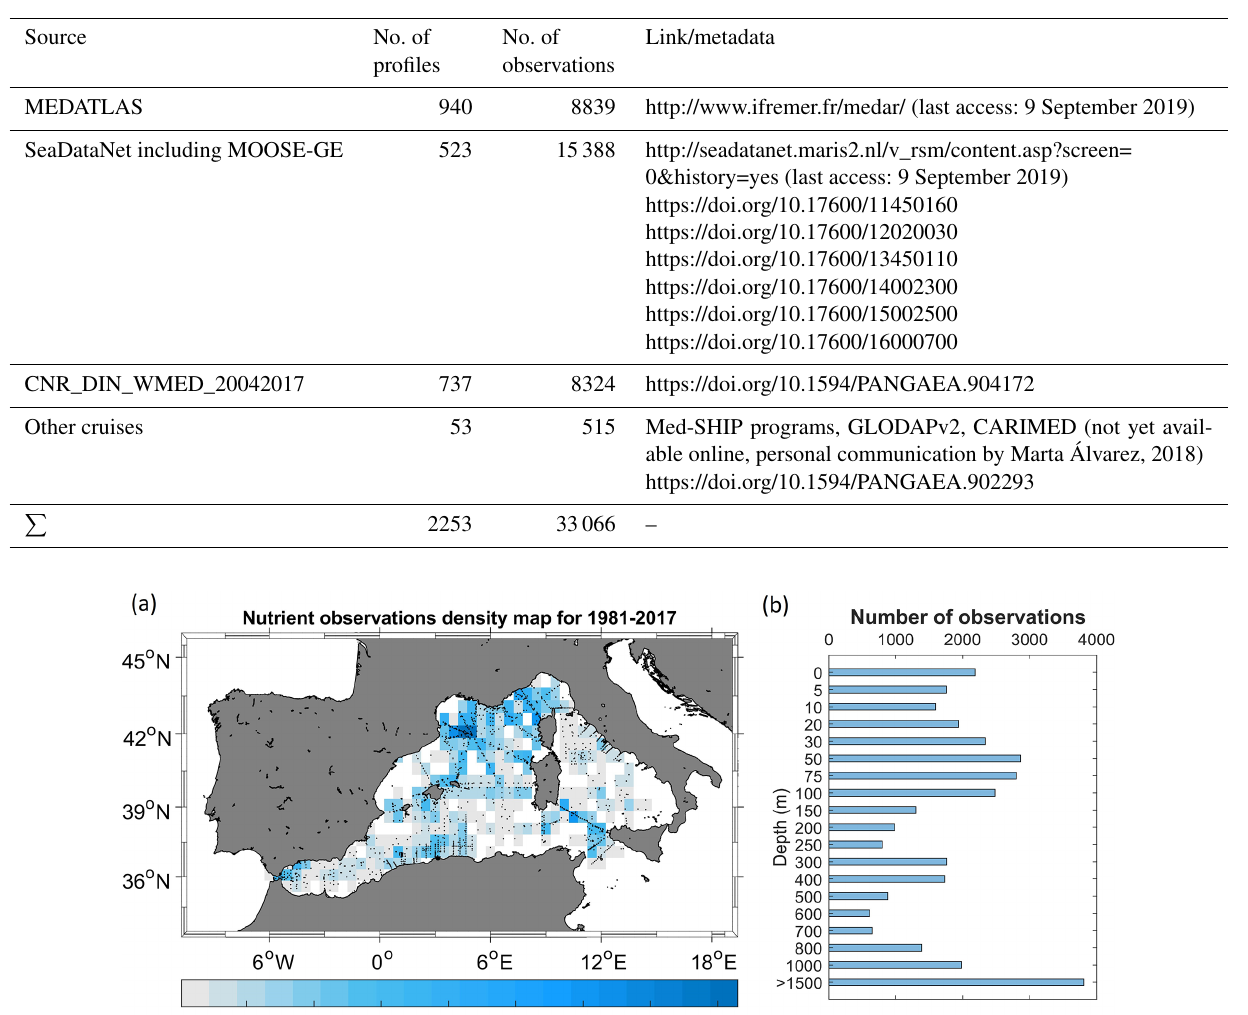
Table 2. Number of inorganic nutrient profiles and data sources.